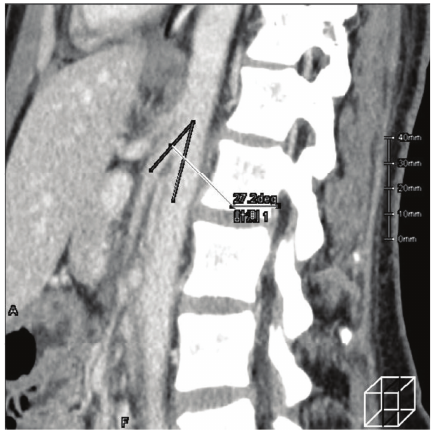
Figure 1: Enhanced computed tomography of transverse section. Left renal vein becomes compressed between the superior mesen- teric artery and the aorta.